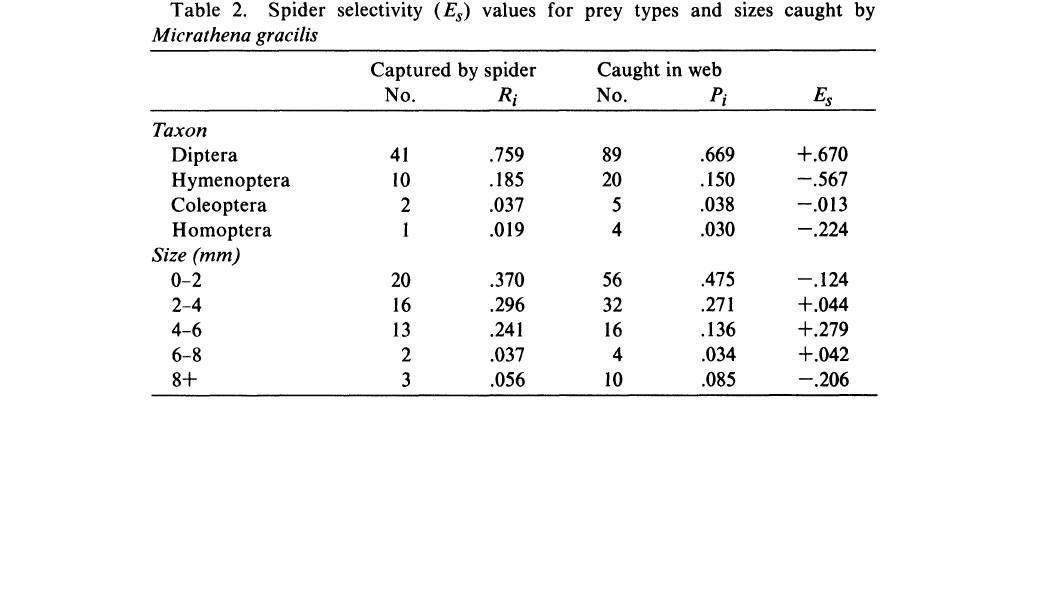
Table 2. Spider selectivity (Es) values for prey types and sizes caught by Micrathena gracilis Captured by spider Caught in web No. R No. Pi